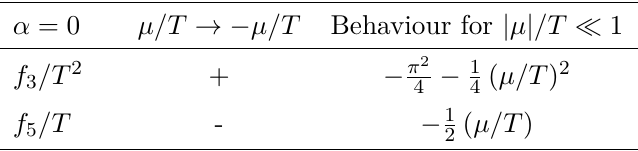
Figure 2 . Behaviour of the dimensionless susceptibilities f 3 /T 2 , f 5 /T as functions of µ/T for the case of vanishing anomaly α = 0 . The susceptibility f 4 vanishes identically in this situation, while the remaining four susceptibilities f 1 , f 2 , f 6 and f 7 stay unaffected by setting α = 0 , with their behaviour still being given by the plots in figure 1.